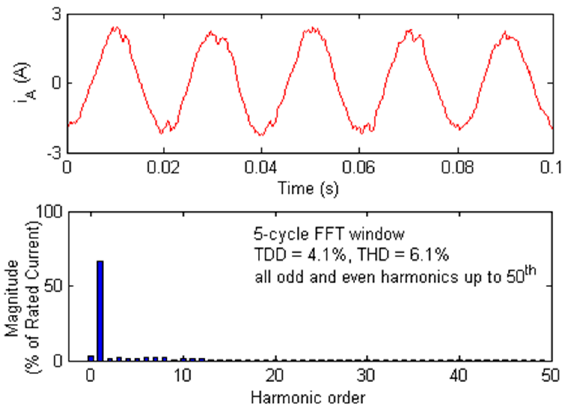
Figure 15. Grid ‐ side line current of PV supply at the top, and its harmonic spectrum at the bottom when delivering 800 VA to the grid at V dc = 667 V. TDD, total demand distortion.